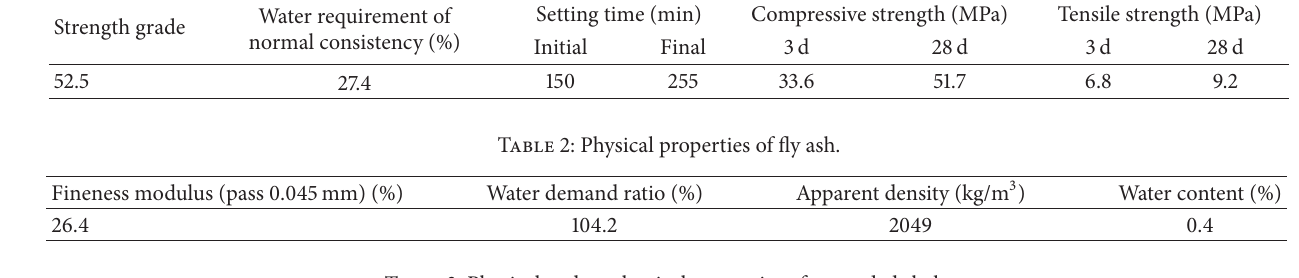
Table 3: Physical and mechanical properties of expanded shale.